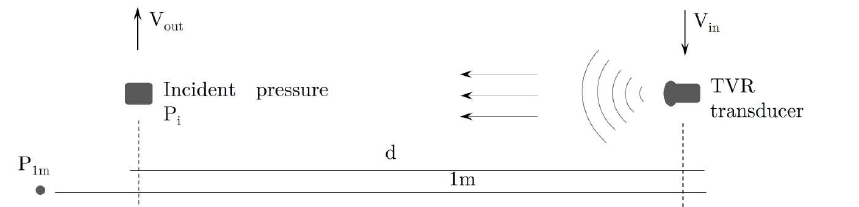
Figure 10. Schematic of the RVR measurement setup.